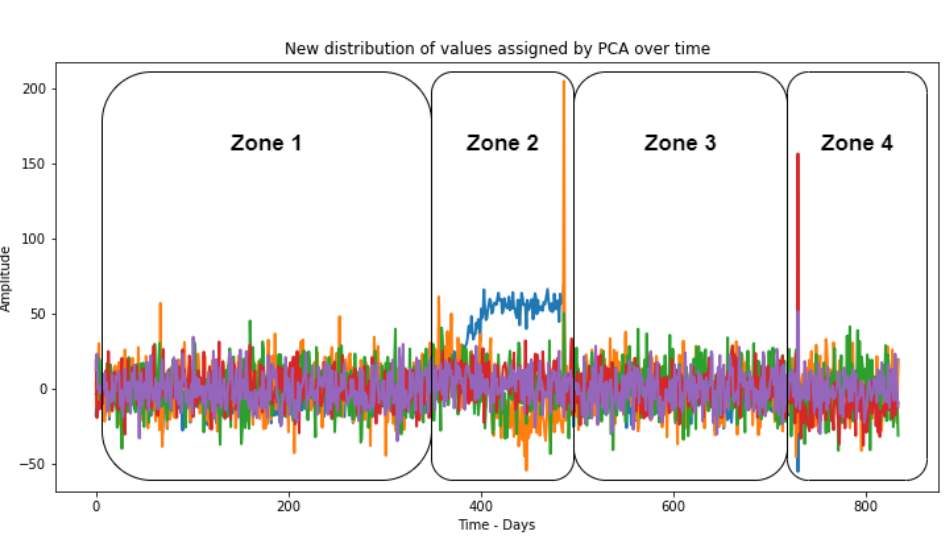
Figure 6. Data movement of the first 10 PCs processed by